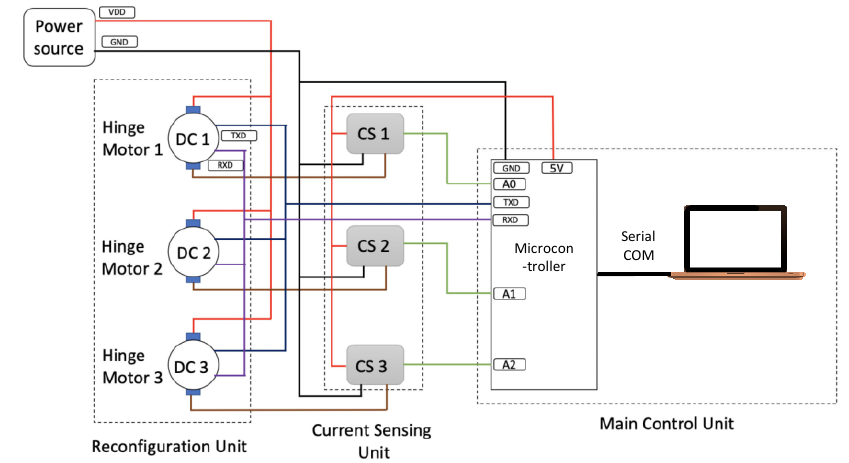
Figure 10. Circuit diagram for logging the current. Experimental steps with video for it can be found at